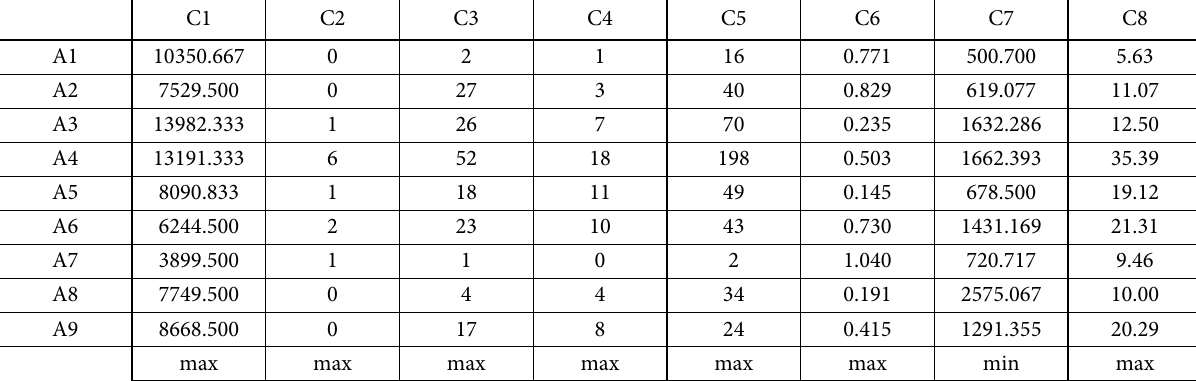
Table 2. Initial decision